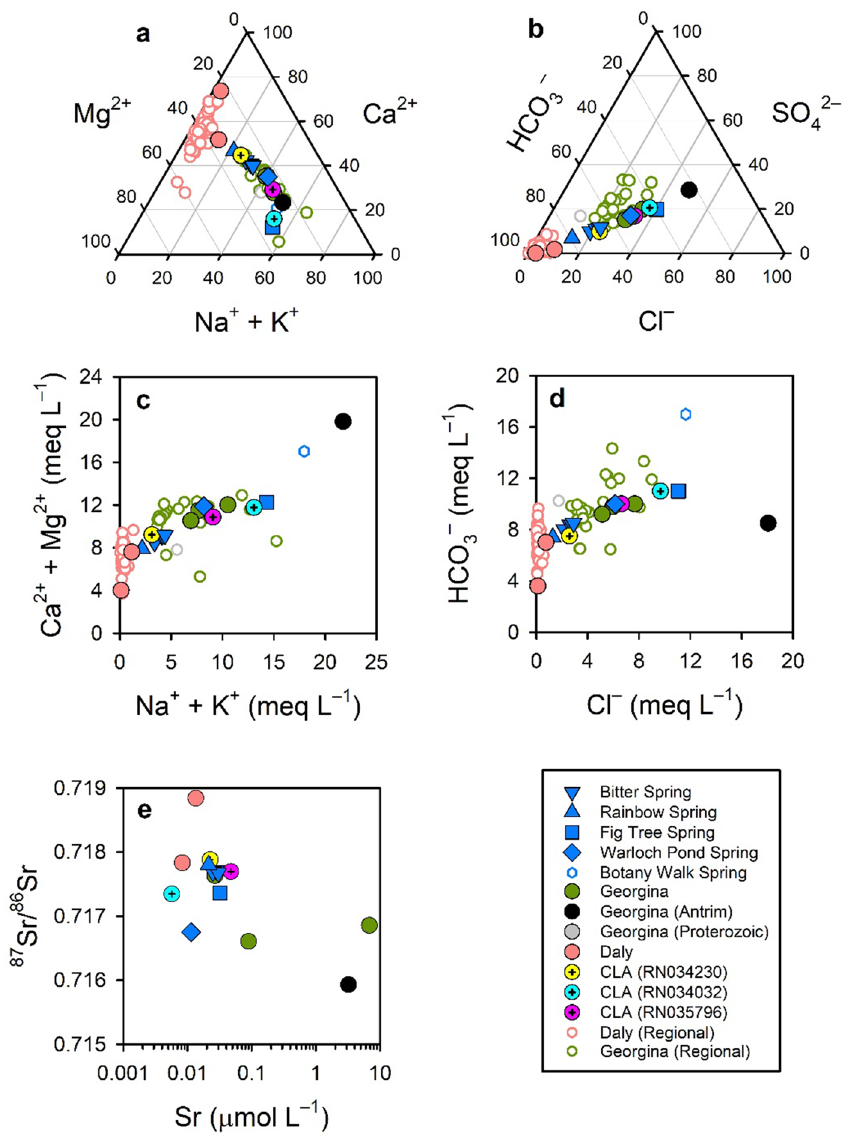
Figure 3. Major ion composition for springs and groundwater samples at the Mataranka Spring Complex and regionally (open symbols; Table S2) for the Georgina and Daly flow paths of the CLA. (a) Ternary plot for major ions; (b) ternary plot for major anions; (c) biplot for mono- relative to divalent cations; (d) Cl – and HCO 3– biplot; (e) Sr and 87 Sr/ 86 Sr. Open symbols are for regional groundwater samples in the Daly and Georgina basins of the CLA and closed symbols are for samples collected in the Mataranka Springs